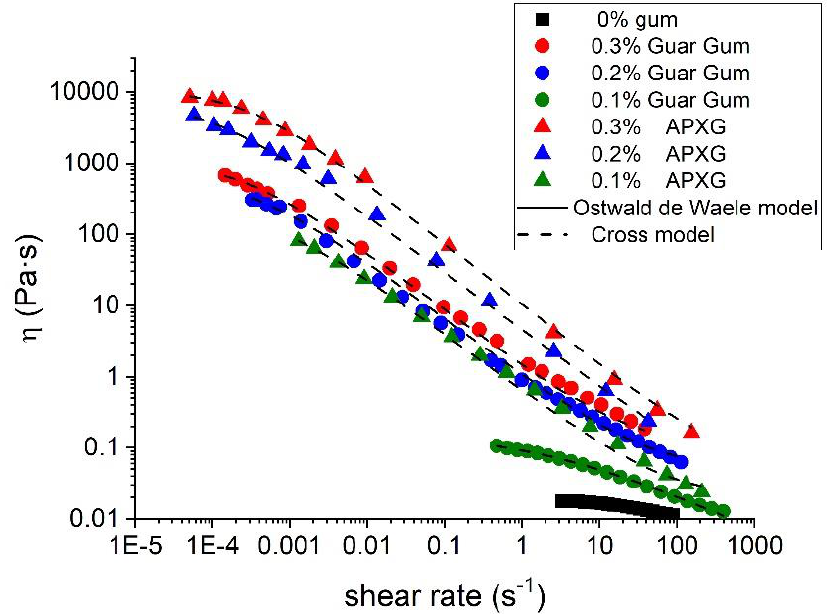
Figure 2. Flow behavior for linseed oil emulsions as a function of gum type and gum concentration. Table 2. Fitting parameter for linseed oil emulsions as a function of gum type and gum concentra- tion.